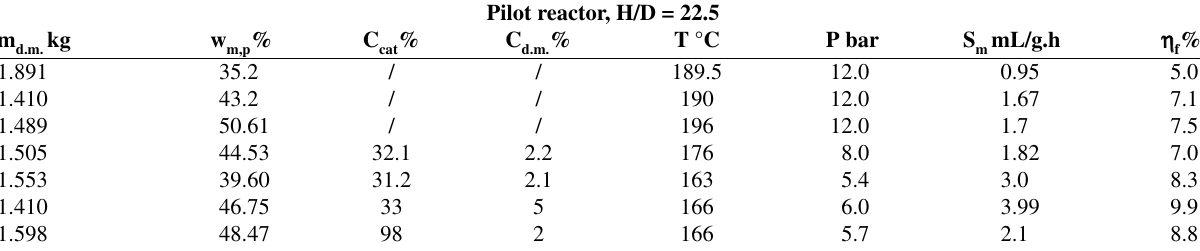
Table 5. Operating conditions and results for some non-catalysed and catalysed pilot experiments. Pilot reactor, H/D =